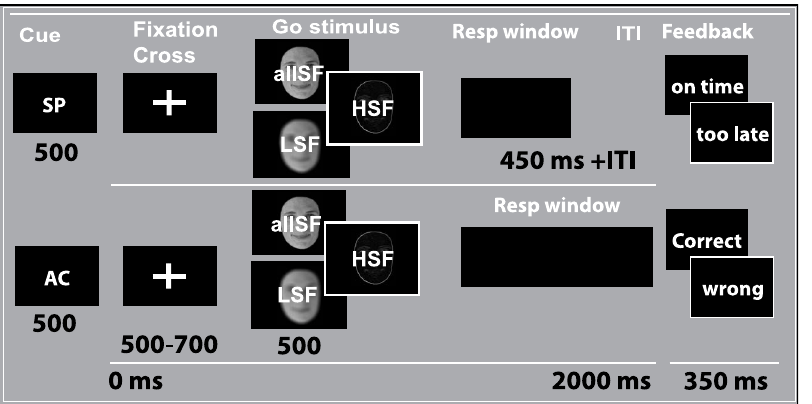
Figure 5. Visual speed-accuracy task. Prior to each trial a cue was presented indicating a speeded (‘‘SP’’) or accurate (‘‘AC’’). The presented face stimulus (male or female) indicated a right- or left- response, and contained allSF, only LSF, or only HSF information. After a speed cue, trials were followed by feedback stating ‘‘on time’’ if responses were below 450 ms, and ‘‘too late’’ if responses were larger than 450 ms. Accuracy trials were followed by feedback stating either ‘‘correct’’ if participants responded correct or ‘‘incorrect’’ when an error was made. For simplicity, the cue and feedback text are displayed here in English, in the real experiment these were provided in Dutch. Prints underestimate contrasts used in the actual experiment, especially for the LSF and HSF pictures. The letters displayed on each face are only included here for clarity and were not on top of the faces during the experiment.